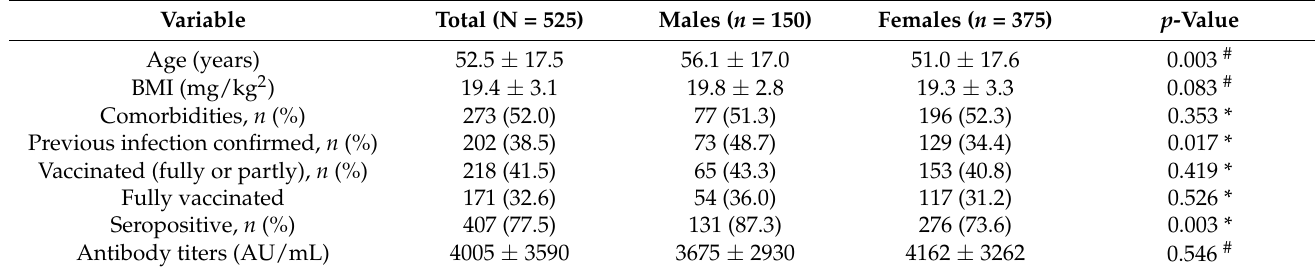
Table 1. Characteristics of the study population in Malesina, stratified by gender (N = 525).